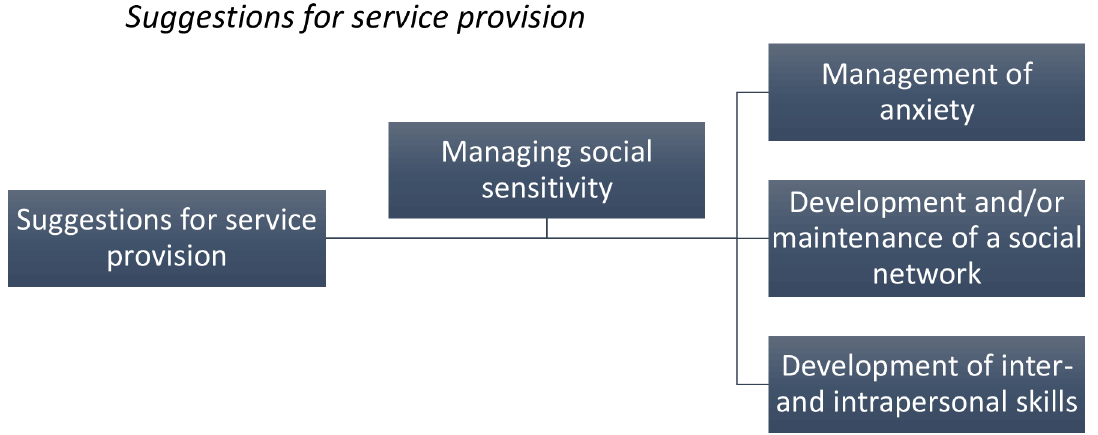
Fig 6. The furthest left hand box indicates the superordinate themes, with the subordinate themes in the remaining boxes. The connecting lines indicate the hierarchical organisation of the